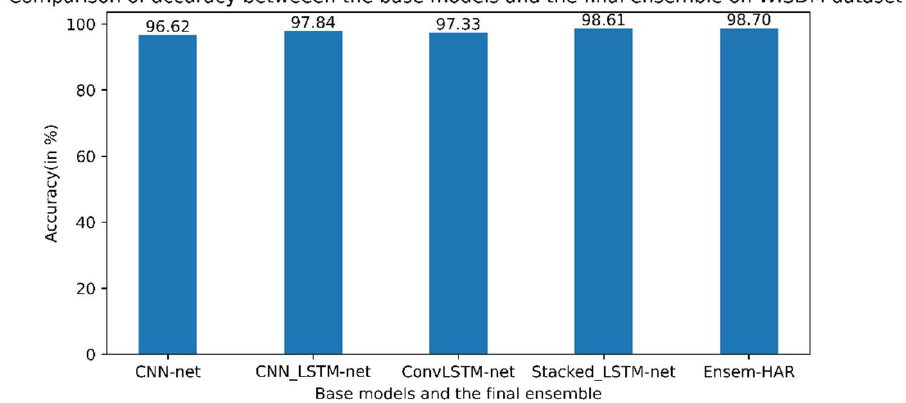
Figure 11. Accuracy (in %) comparison between four base models and Ensem-HAR model on the WISDM dataset.